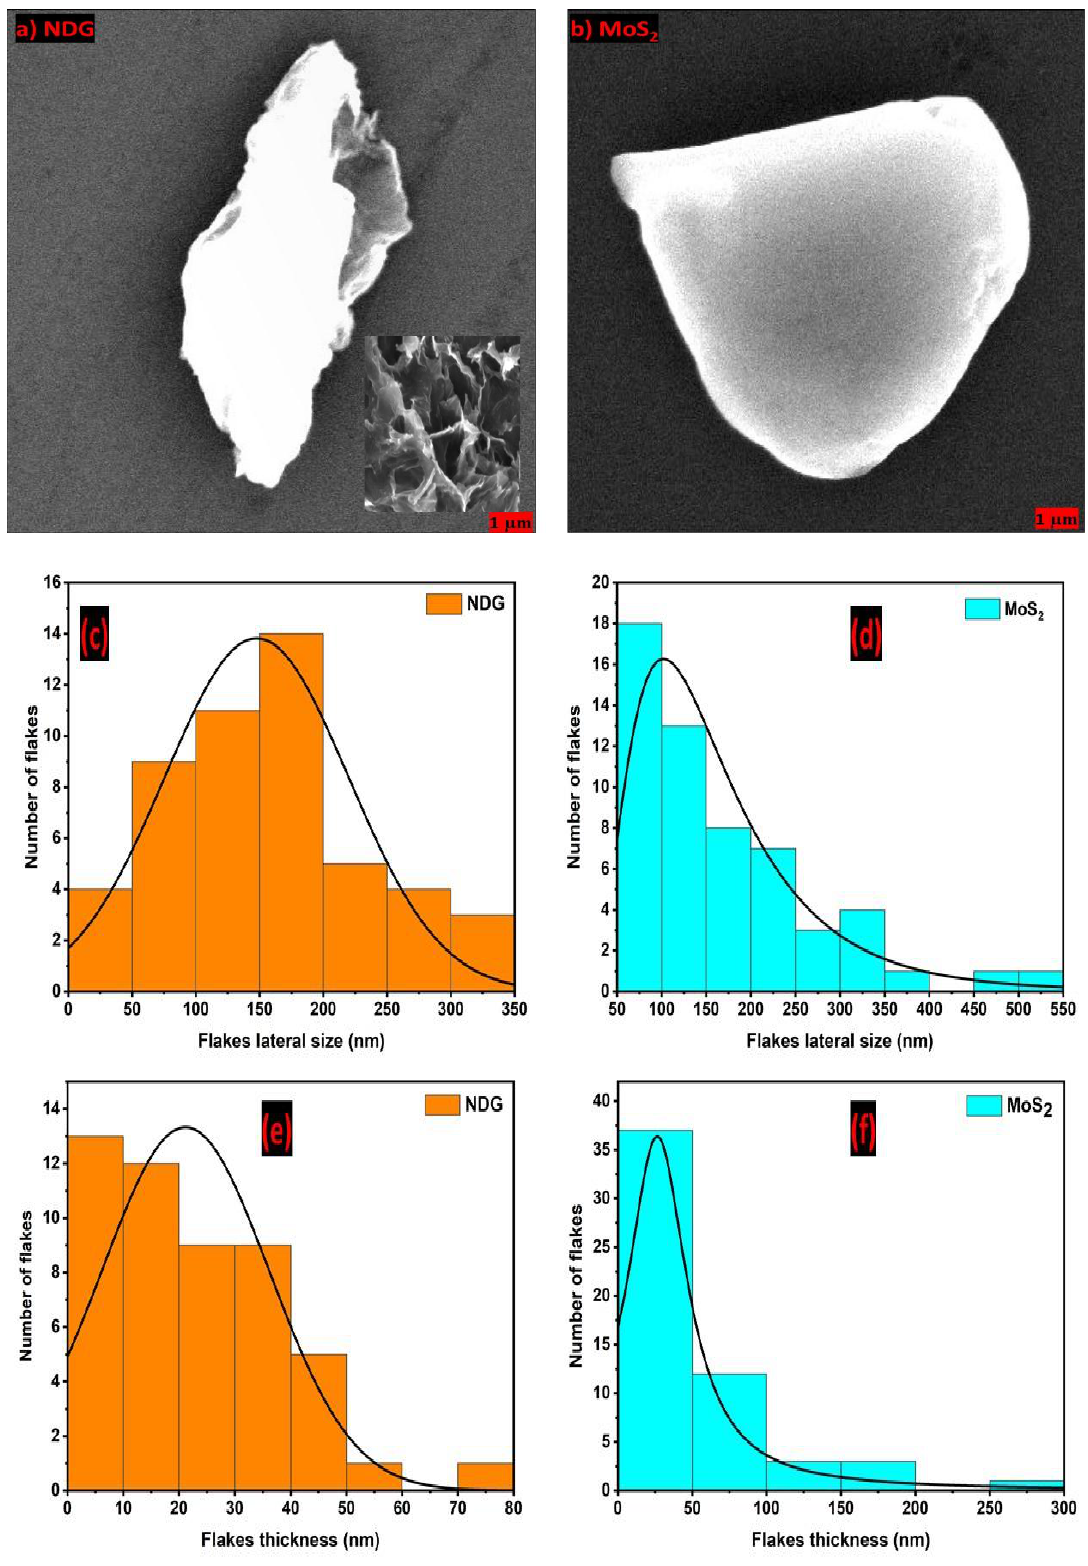
Figure 1. Scanning electron microscopy (SEM) images of ( a ) bulk nitrogen-doped graphene (NDG) nanosheets (inset: SEM image of broken NDG nanosheets), and ( b ) molybdenum disulfide (MoS 2 ) as-purchased flakes. Lateral size distribution from atomic force microscopy (AFM) measurements of ( c ) NDG and ( d ) MoS 2 flakes. Flake thickness distribution of ( e ) NDG and ( f ) MoS 2